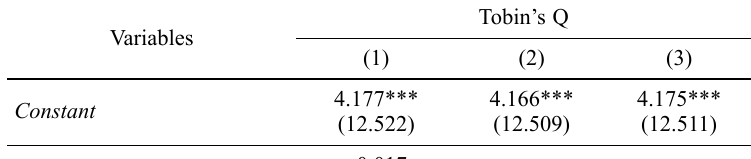
Table 3. Relation between issuance of detachable BWs and firm